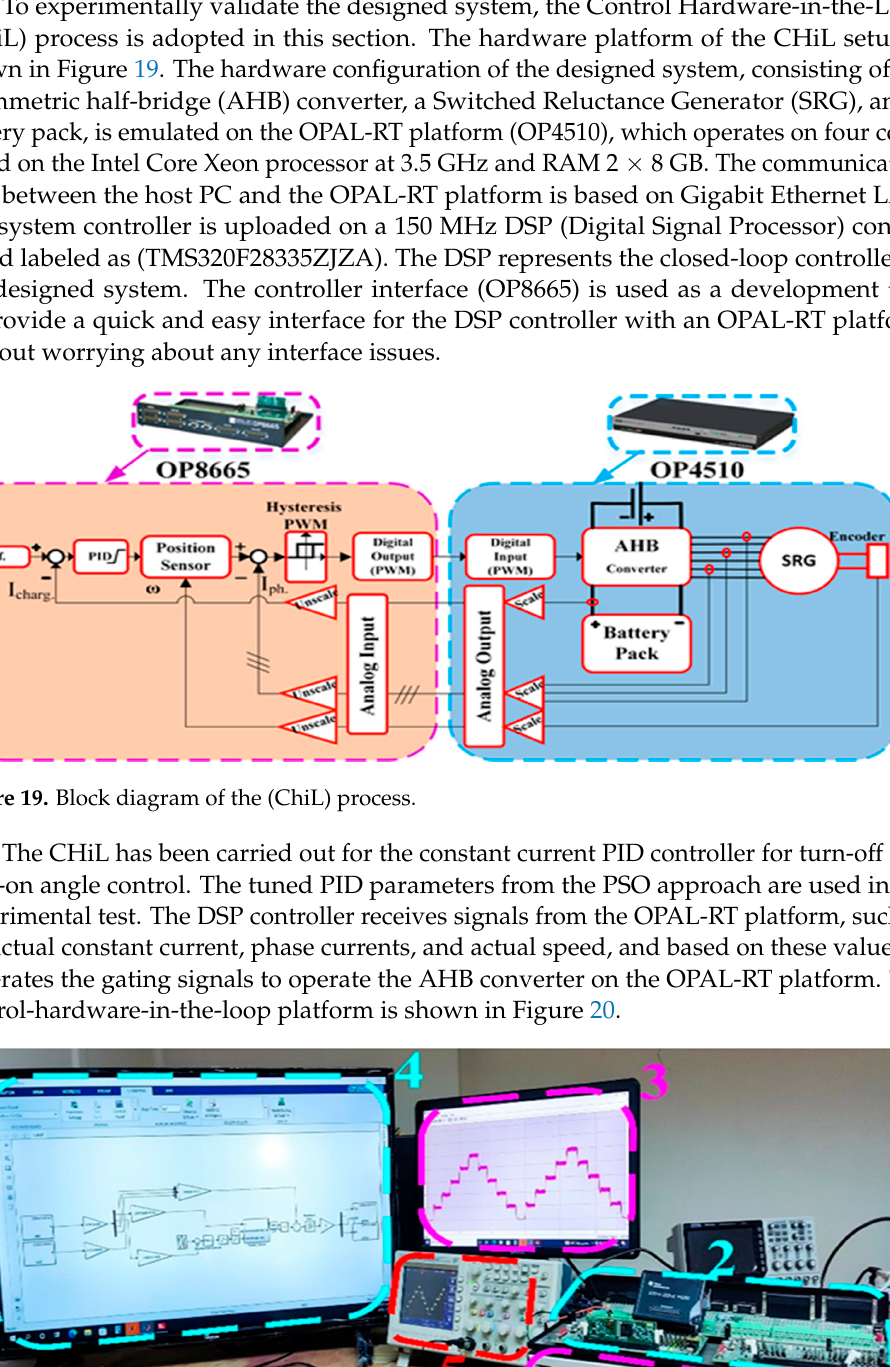
( b ) Figure 18. Constant (charging) current response for turn-on angle control, ( a ) transient current at different reference currents, and ( b ) maximum generated current at different turn-off angles. 7. Experimental Validation